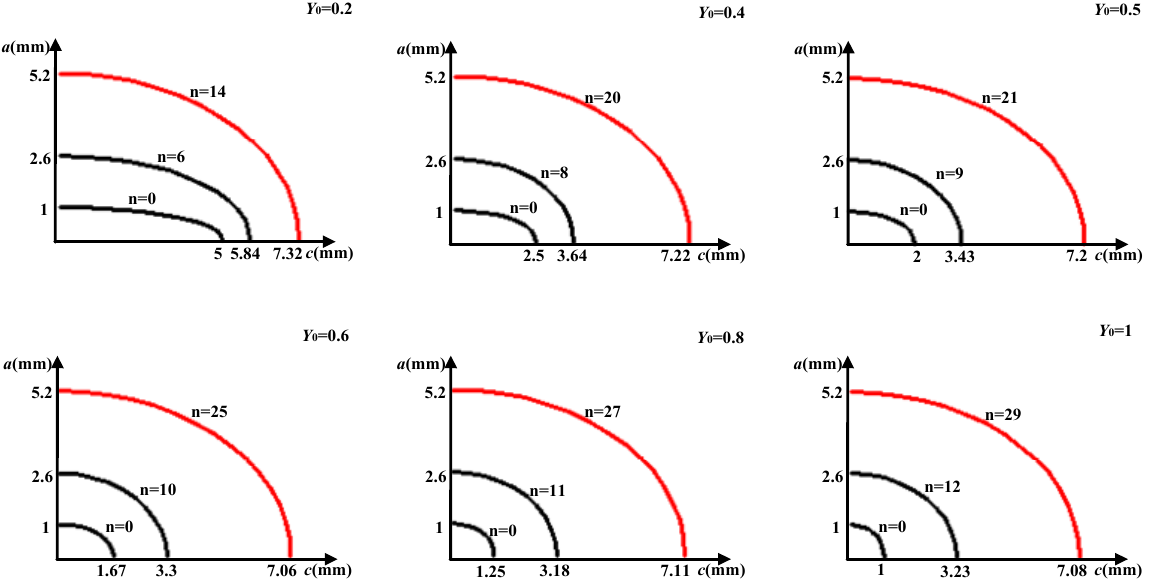
Figure 7. The shape evolution of the semi-elliptical surface crack growth under different initial shape ratios. According to the shape of the crack front at each propagation step, the ratio of the crack depth a to the critical dimension a c was taken as the abscissa, and the shape ratio change trend of the initial semi-elliptical surface crack during the propagation process was obtained, as shown in Figure 8. The crack depth development speed is higher than the lateral development when Y 0 = 0.2. When Y 0 is between 0.4 and 0.8, the transverse crack growth rate is higher than that in depth, and it develops very fast first and then tends to level off. The trend of cracks is also that the lateral development speed is higher than the depth development when Y 0 = 1. As the semi-elliptical surface cracks with different shape ratios propagate to the critical size, the final shape ratio of the cracks tends to a constant